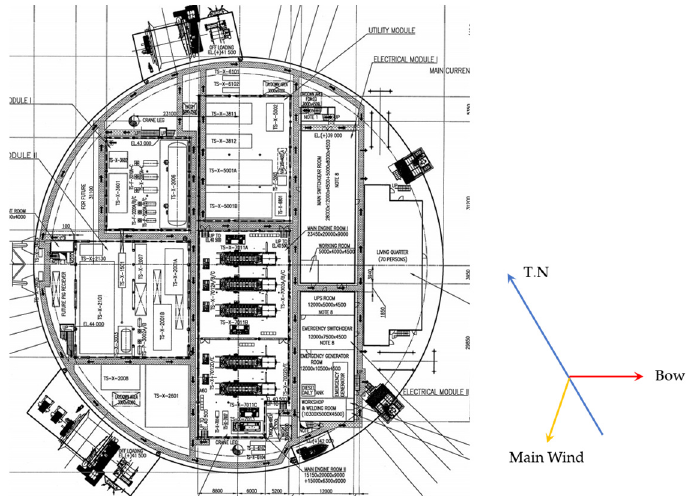
Figure 3. Installation heading for LH11-1 FPSO (related to True North).